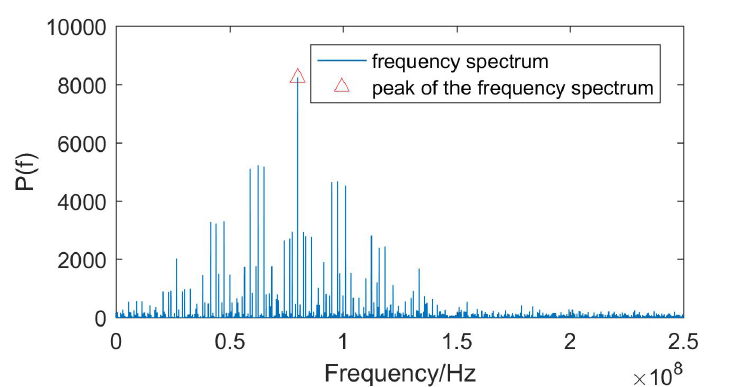
Figure 6. Spectra of the detector output signal and its